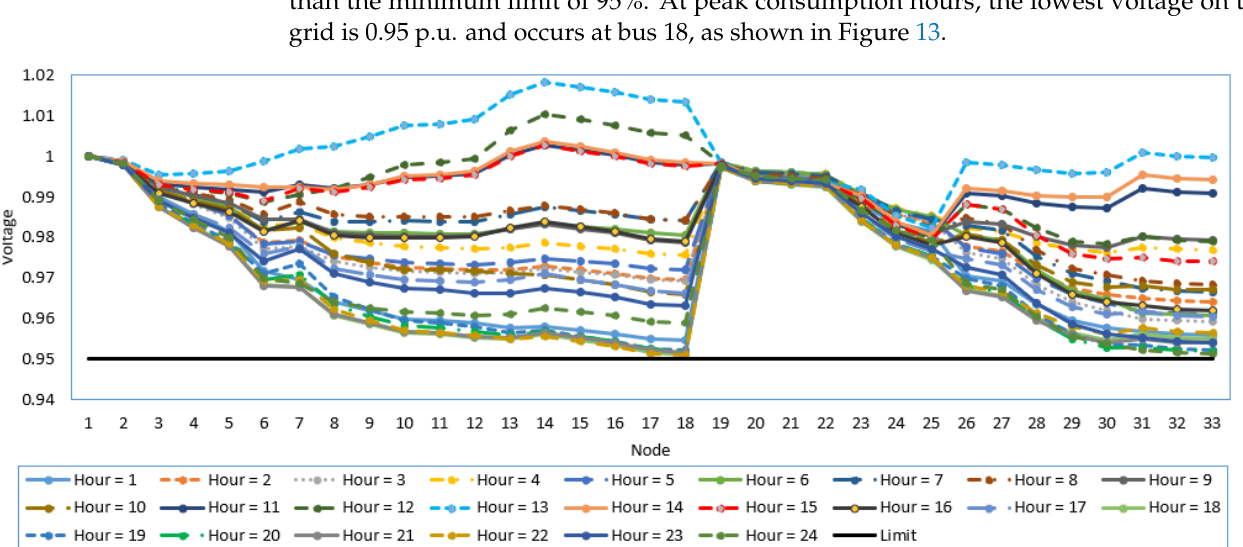
the IEEE 33-distribution system .